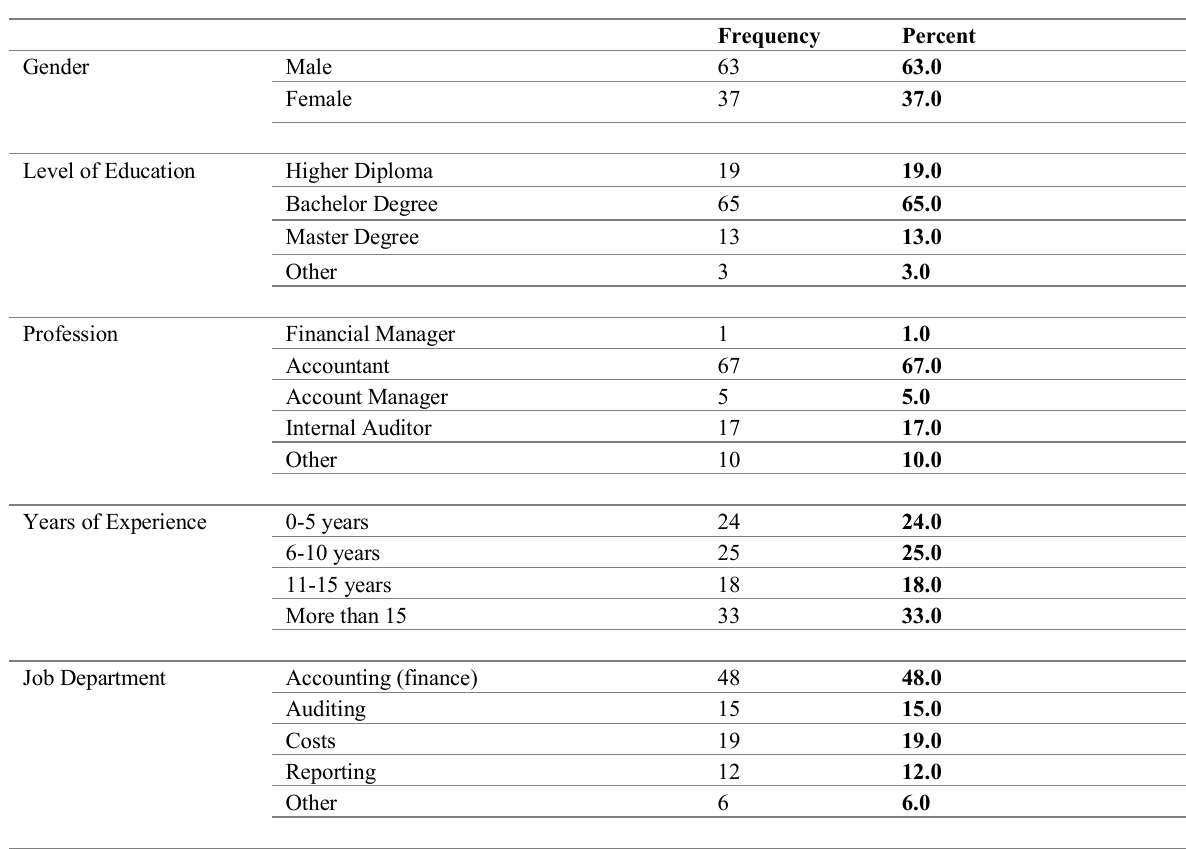
Table 5: All Characteristics of